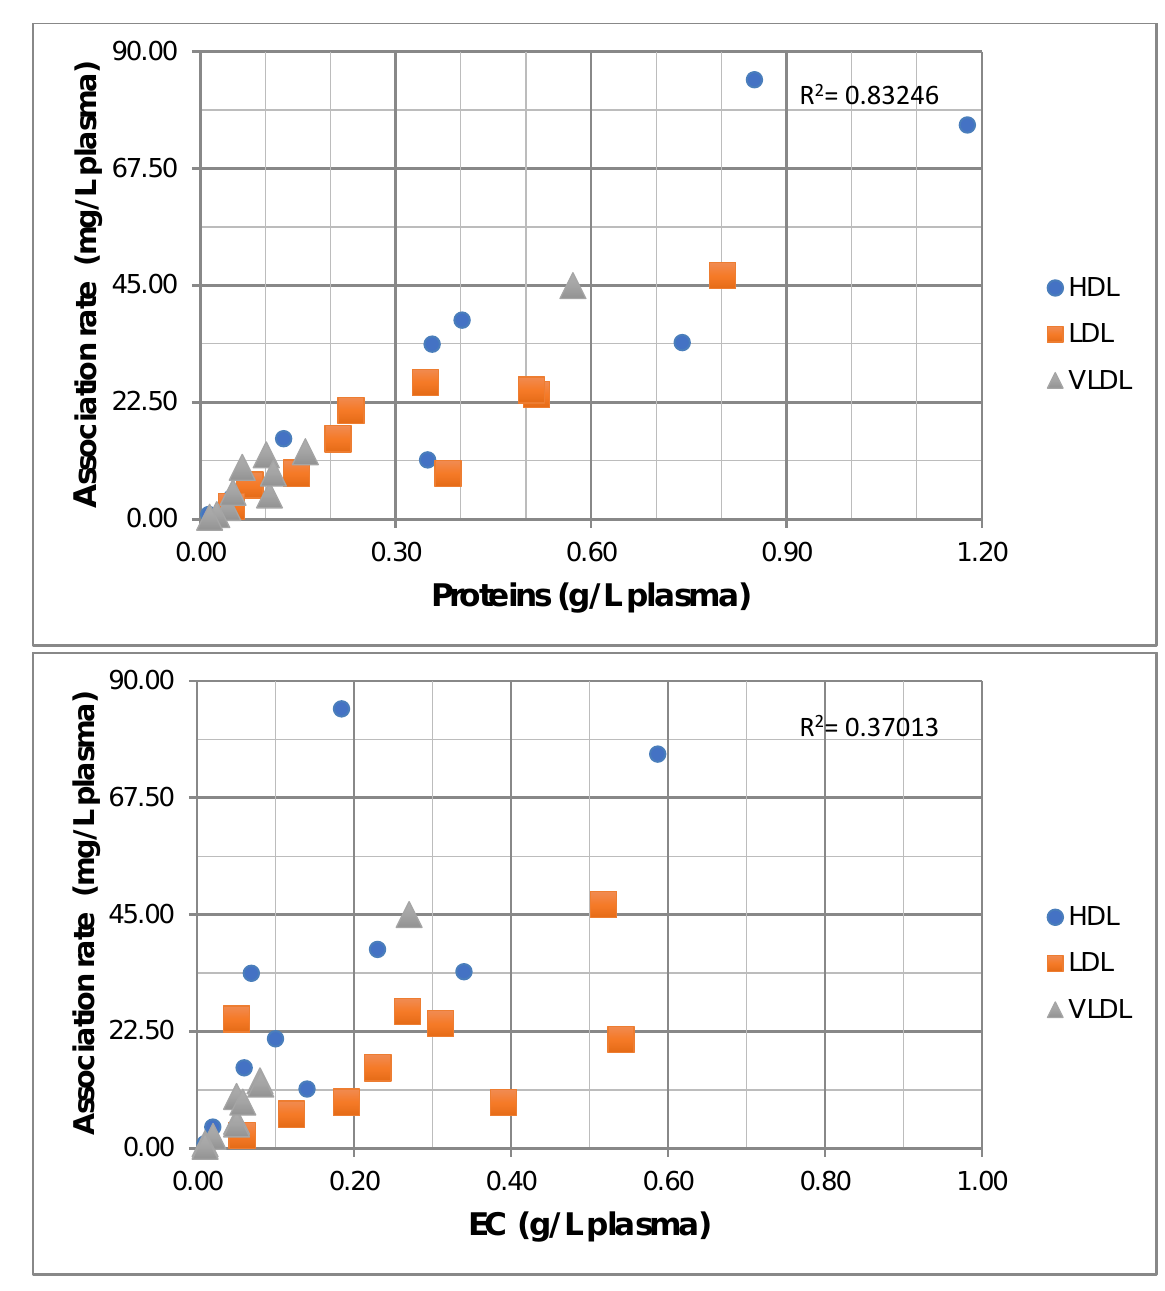
Figure 1. A correlation between the concentration of lipoprotein components and the cyclosporine association rate; ( A ): triglyceride concentration, ( B ): phospholipids concentration, ( C ): total cholesterol concentration, ( D ): free cholesterol concentration, ( E ): proteins concentration, ( F ): esterified cholesterol concentration. Table 2. Effect of lipoprotein type and composition on the association efficiency of cyclosporine A. Lipoprotein Correlation Coefficient Between LPs’ Different Components and Association Lipoprotein